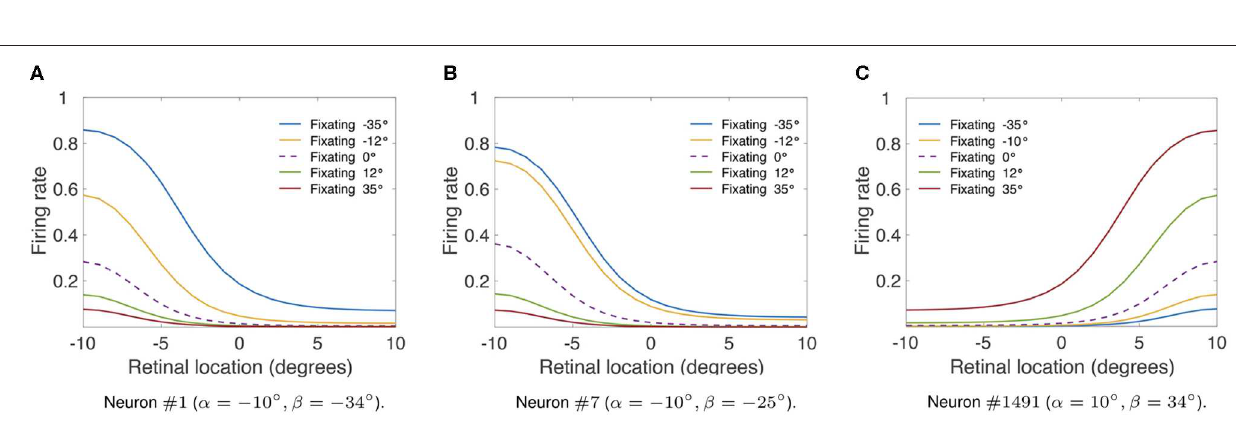
Frontiers in Neural Circuits | www.frontiersin.org